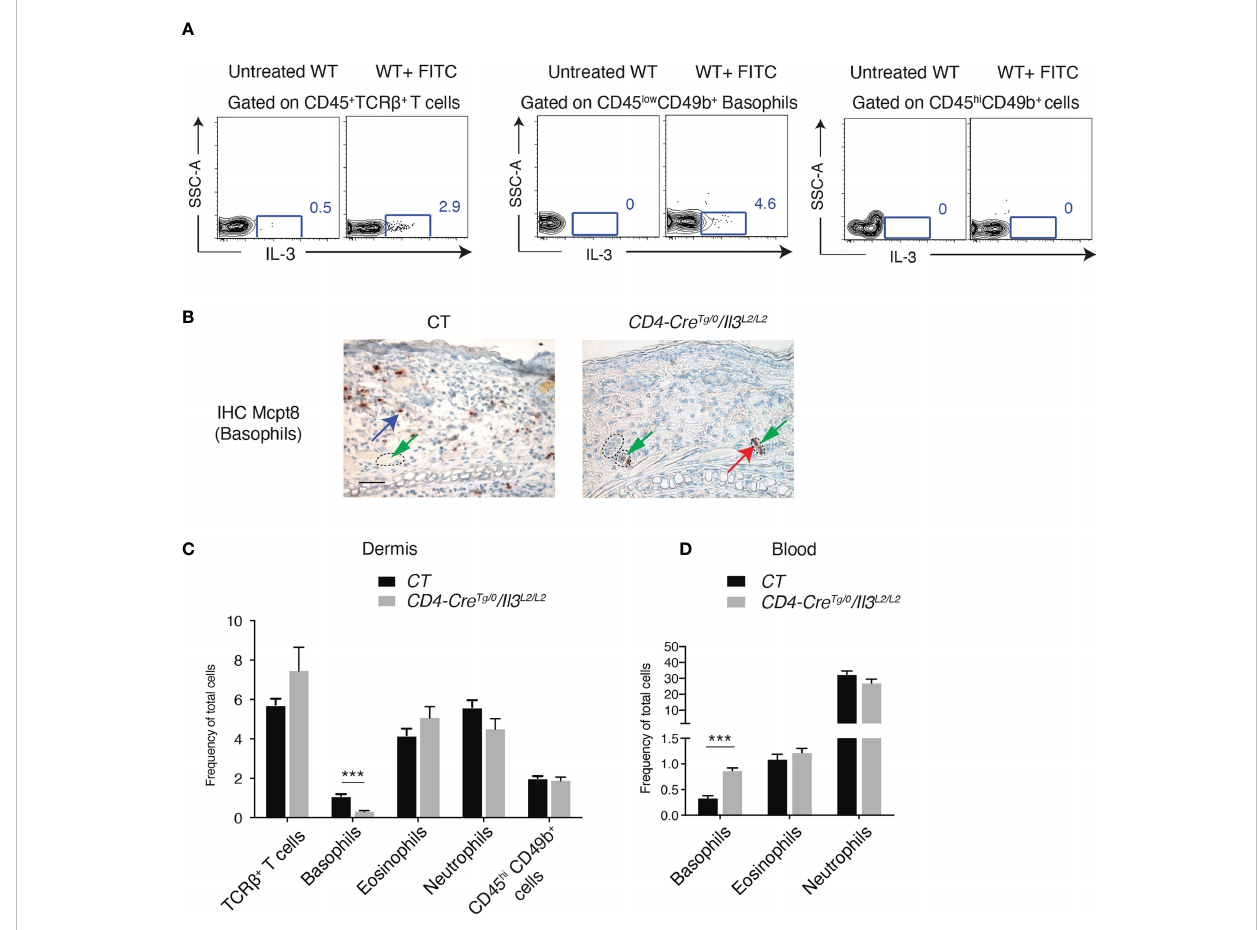
FIGURE 4 IL-3 produced by T cells mediates basophil extravasation to FITC-induced ACD skin. (A) Intracellular staining of IL-3 in dermal cells of RES from untreated or FITC-treated Balb/c WT mice. (B) IHC staining with Mcpt8 antibody in RE of FITC-treated CD4-Cre 0/0 / Il3 L2/L2 (CT) and CD4-Cre Tg/0 / Il3 L2/L2 mice. Red arrow points to one of basophils inside blood vessels and blue arrow points to one of basohils of our blood vessel. Dashed circles outline blood vessels. Scale bar, 50 m m. (C) FACS analyses of dermal cells of REs from FITC-treated CT and CD4-Cre Tg/0 / Il3 L2/L2 mice, for CD45 + hematopoietic cells, CD45 + TCR b + T cells, CD45 + TCR b - Siglec-F + Gr1 low-neg (eosinophils), and CD45 + TCR b - Gr1 hi (neutrophils), CD45 low CD49b + Siglec-F - Gr1 - (basophils) and CD45 hi CD49b + Siglec-F - Gr1 - cells (which contain mast cells). (D) FACS analyses of blood cells from FITC-treated CT and CD4-Cre Tg/0 / Il3 L2/L2 mice for CD19 - CD3 - Gr1 low-neg SiglecF - IgE + (basophils), CD19 - CD3 - Siglec-F + Gr1 low-neg (eosinophils), and CD19 - CD3 - Gr1 hi (neutrophils). ***P ≤ 0.001 (Student's t-test). Values are mean ± SEM (n=4 mice per